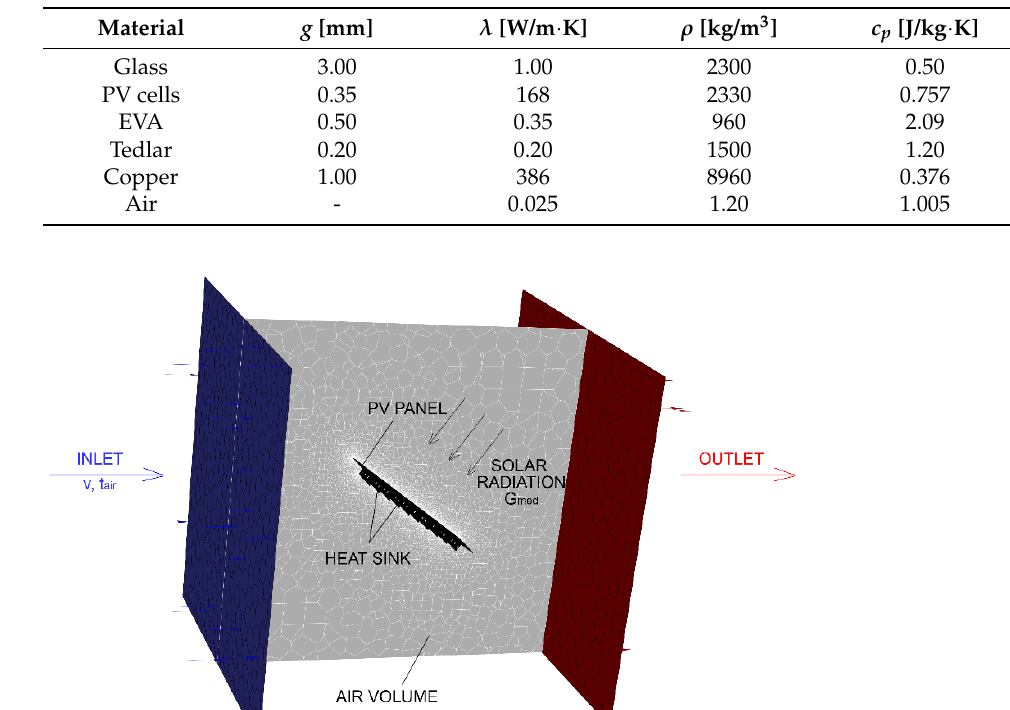
Table 2. Material properties.